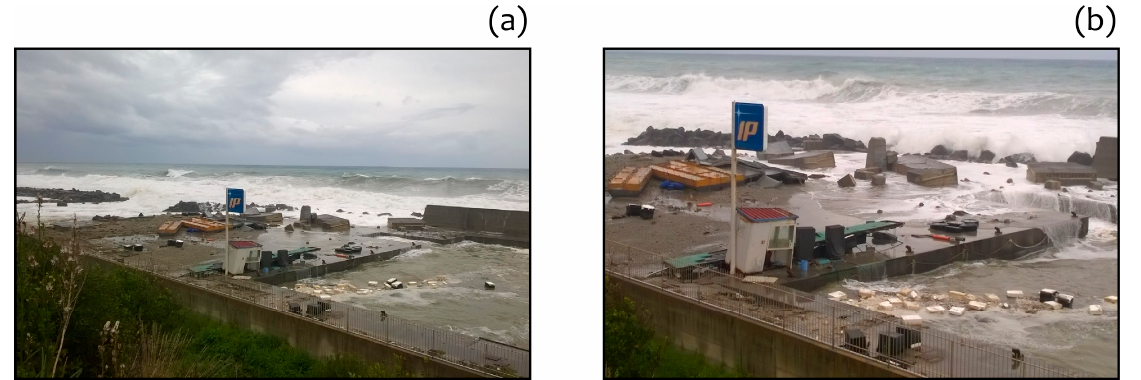
Figure 12. ( a , b ) Damages produced by the storm that occurred on 21 March 2018 to the assets of Belvedere Marittimo Port.